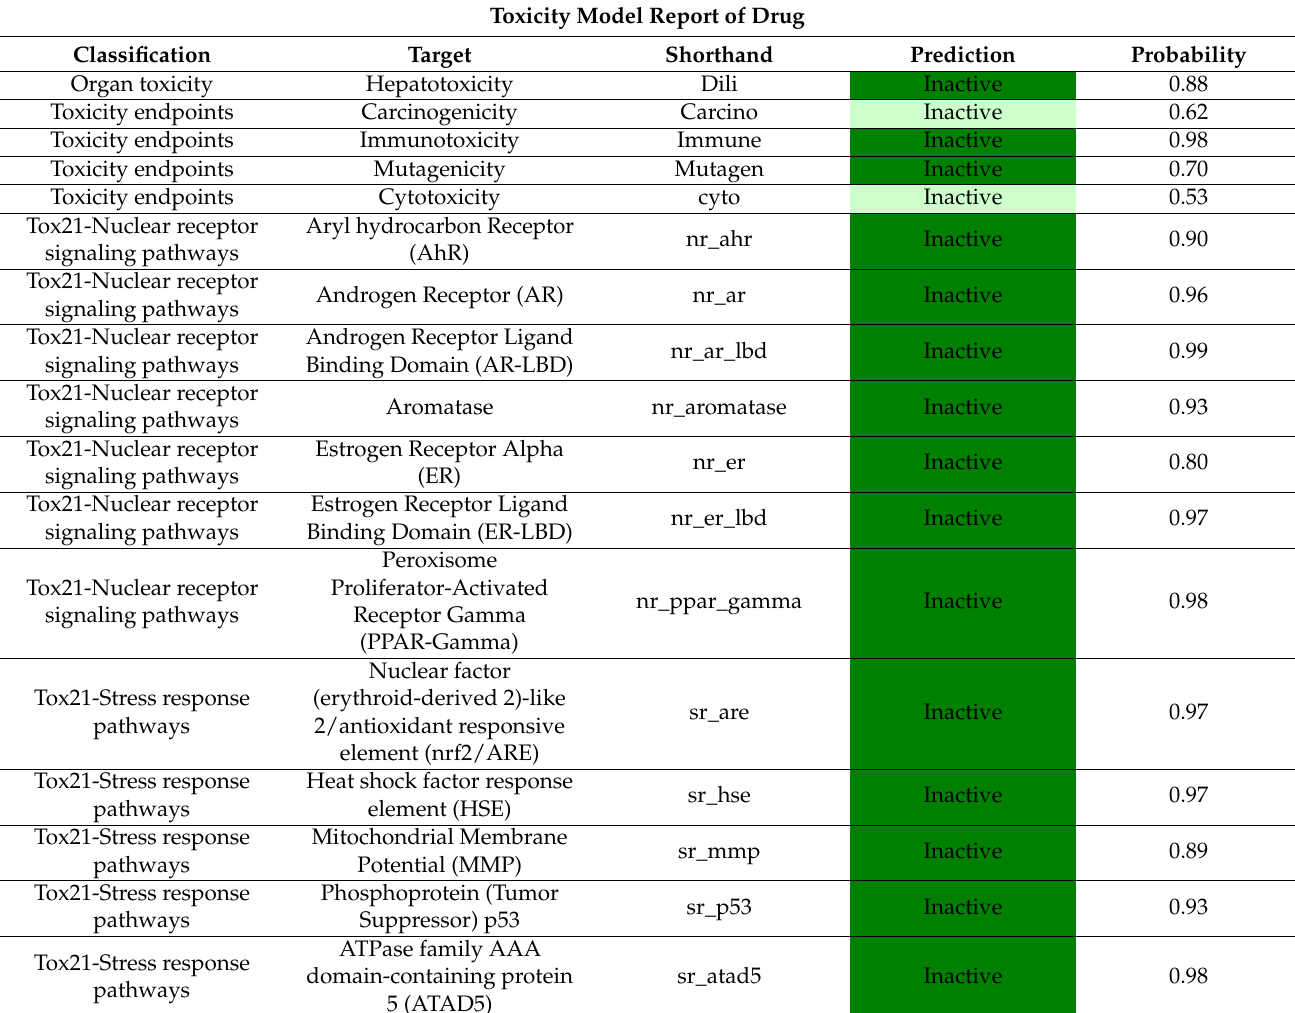
Table 5. The toxicity analysis of AIGT from ProTox-II. Toxicity Model Report of